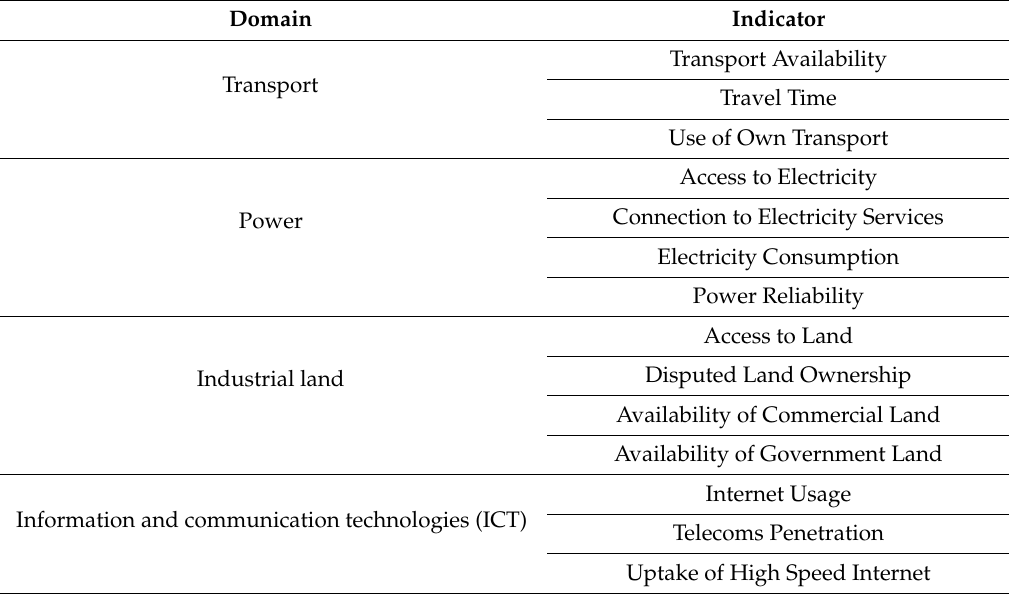
Table 9. Final List of CIQI